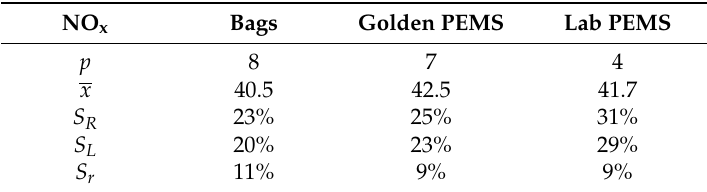
Table A3. Statistical analysis results for NO x .